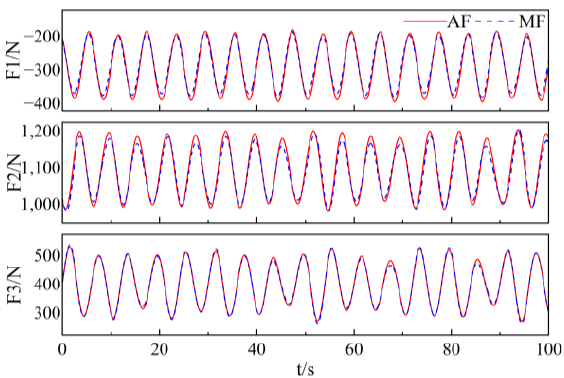
Figure 12. Tractive force of each drive support chain of the stable platform under the dynamic load.